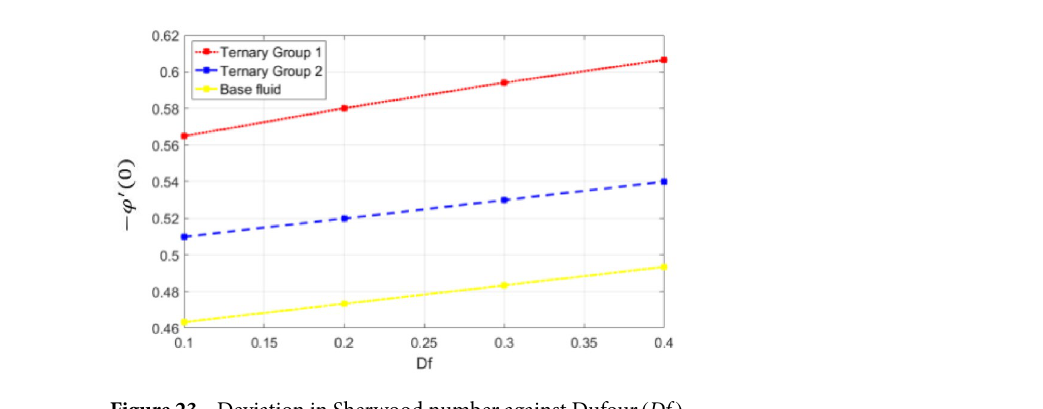
Figure 23. Deviation in Sherwood number against Dufour ( Df )